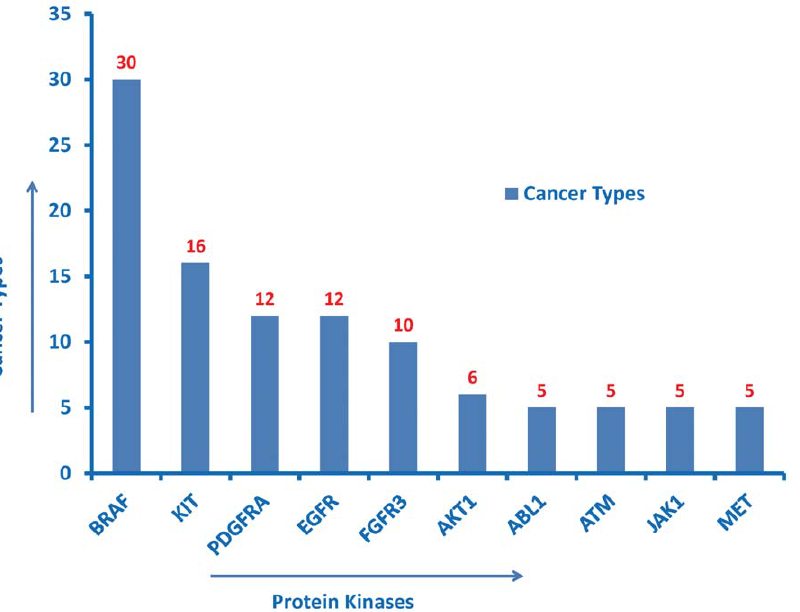
Figure 5. Counts of different cancer types implicated in protein kinases. Top ten kinases are in descending order of their values. The SPARQL query to generate this figure can be directly viewed and excuted from the ProKinO browser by selecting ‘‘Query 4’’ under the ‘‘Example queries’’ tab in the main page.